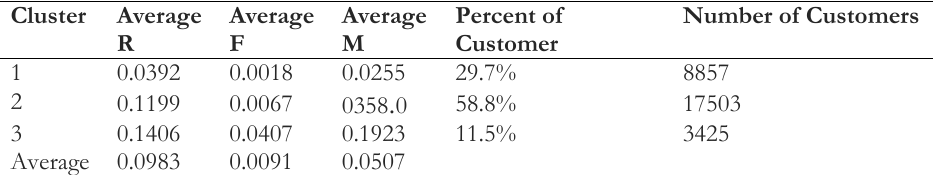
Table 7. Details clustering according to K-means algorithm.